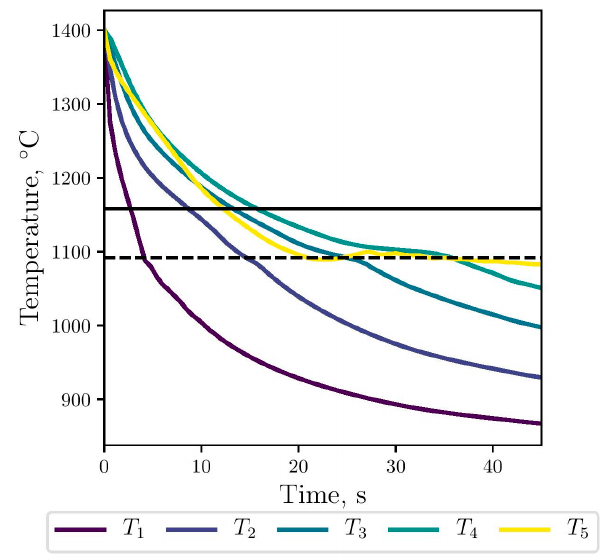
Figure 7. Numerical cooling curves for the selected points at the thimble, against stable (black line) and metastable (dashed line) transformation temperatures.